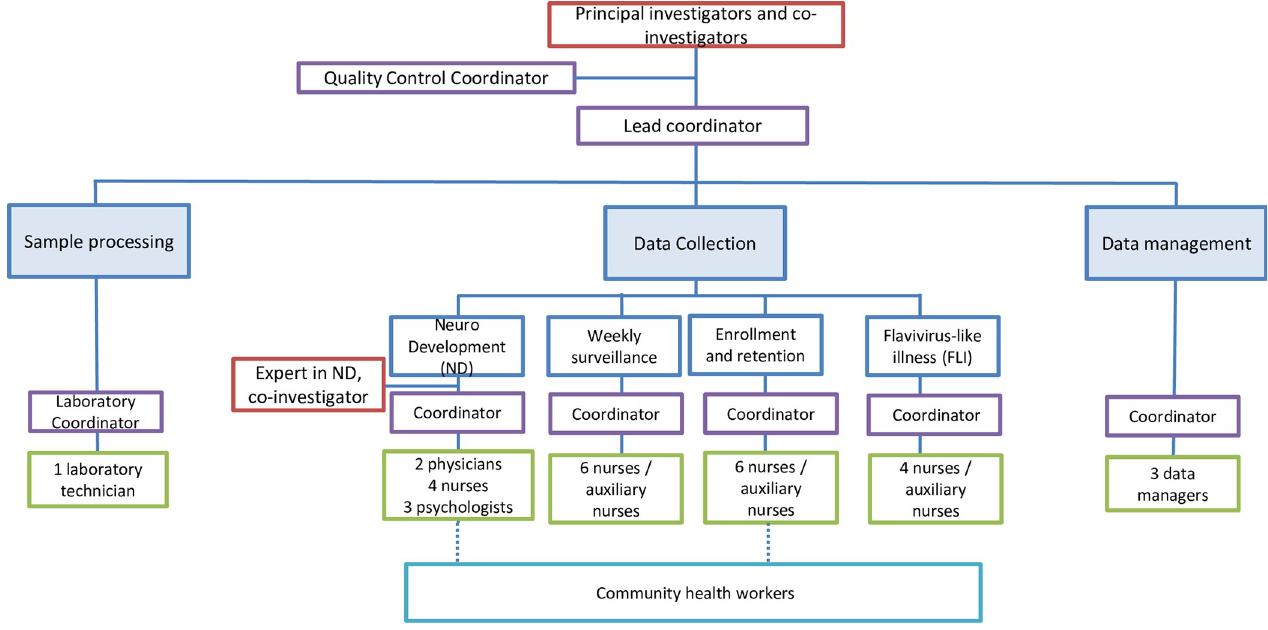
Fig 1. Organization of competency-based